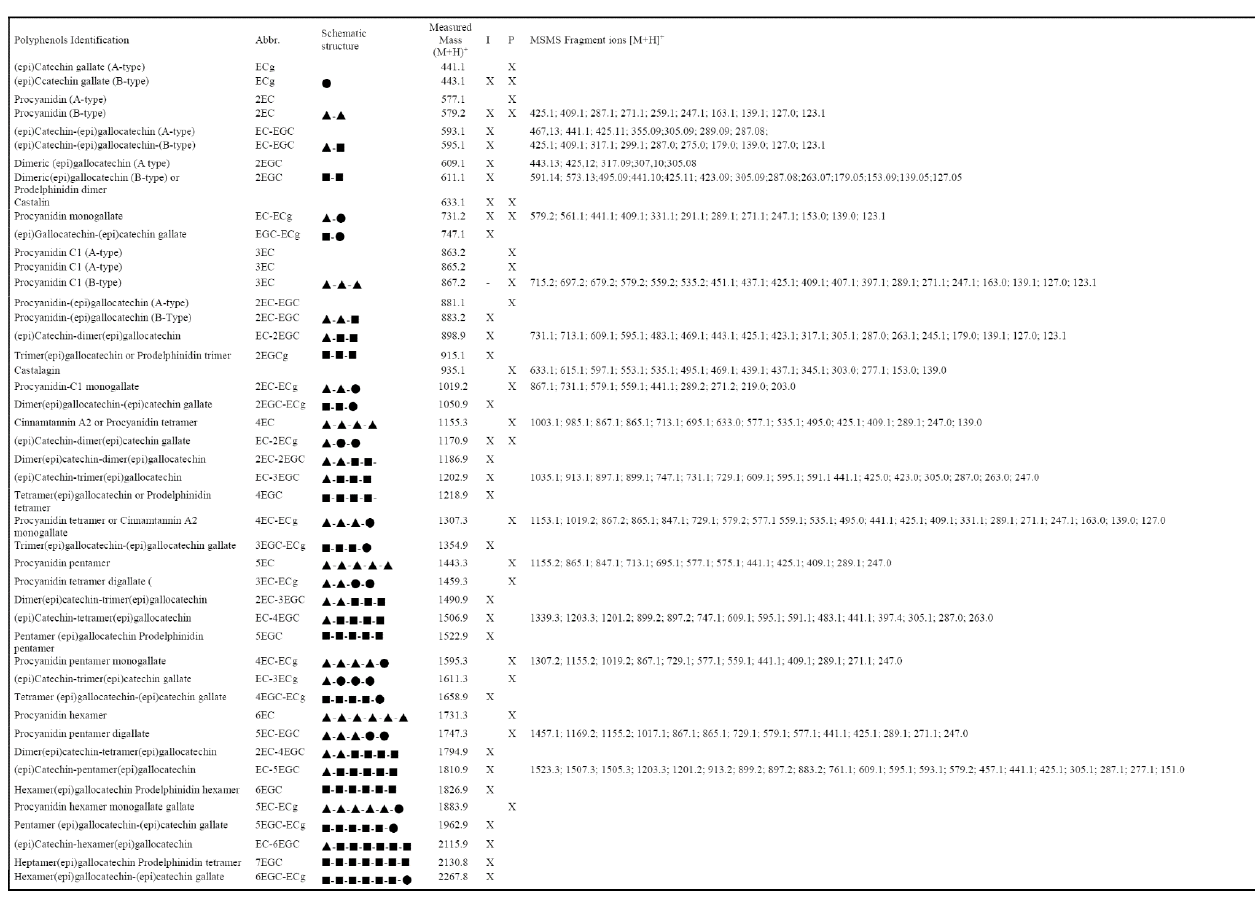
Figure 4. List of polyphenols identified in chestnut pericarp and integument extracts (Figure 3A,B), along with their measured mass values ascertained by ESI-qTOF-MS analysis in positive ion mode and major diagnostic fragment ions recorded for each precursor ions. I, integument; P, pericarp; EC, (epi)catechin, (cid:78) ; EGC, (epi)gallocatechin, (cid:4) ; ECg, (epi)catechingallate, • .